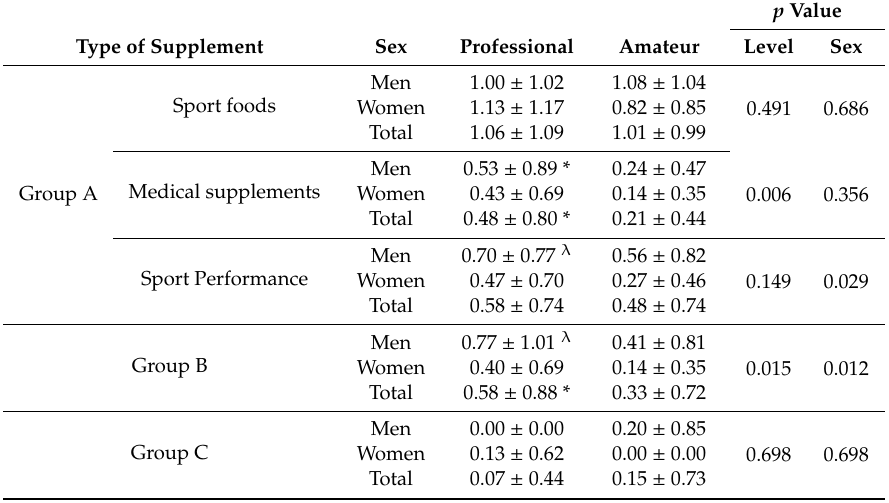
Table 2. Number of supplements used in handball players depending on sex and competitive level.